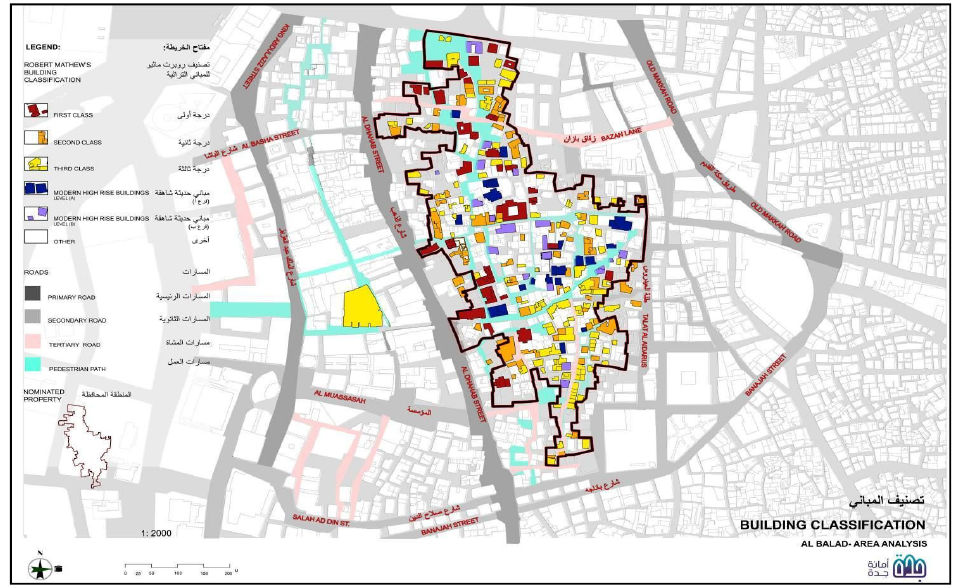
Figure 5. Matthew classification used in the historical area of Jeddah [16] .